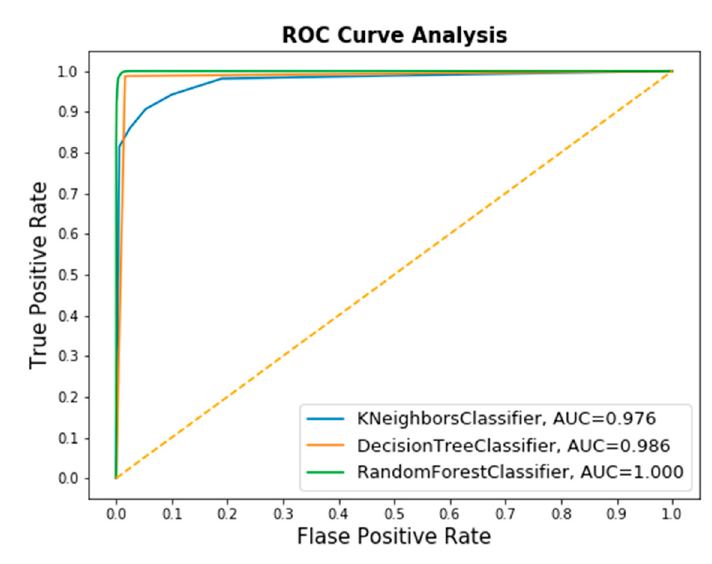
Figure 12. Combined ROC curve for the KNN, decision tree, and random forest classifiers.